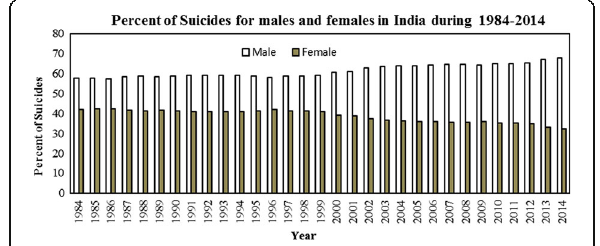
Fig. 2 Percent of Suicides for males and